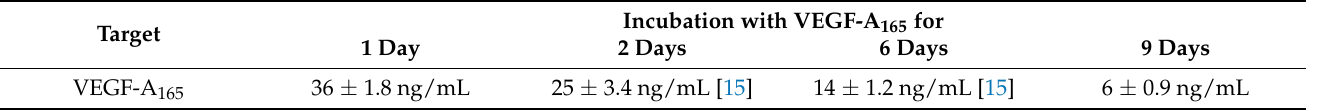
Table 3. Responses of iBREC to VEGF-A 165 depend on exposure time: concentrations of VEGF-A 165 in cell culture supernatant.